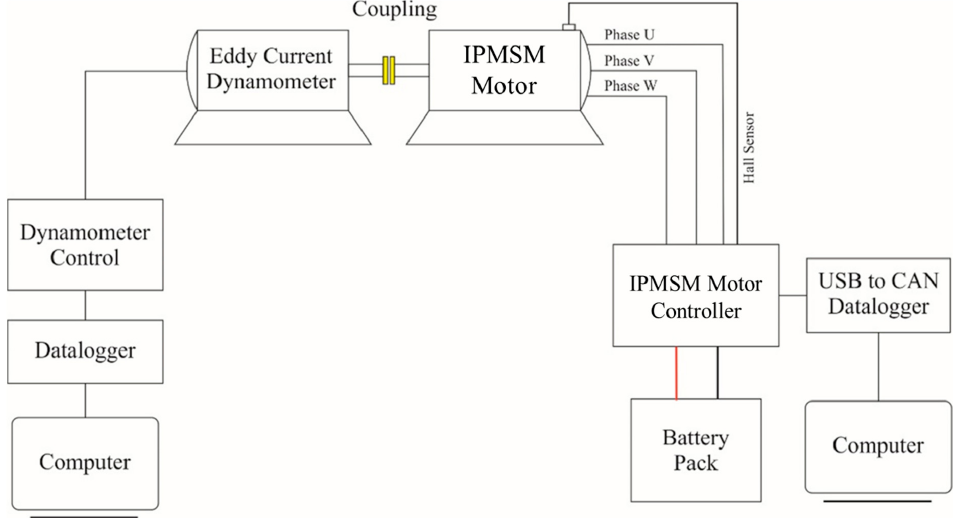
Figure 16. Experimental set-up of IPMSM and its controller performance measurement.